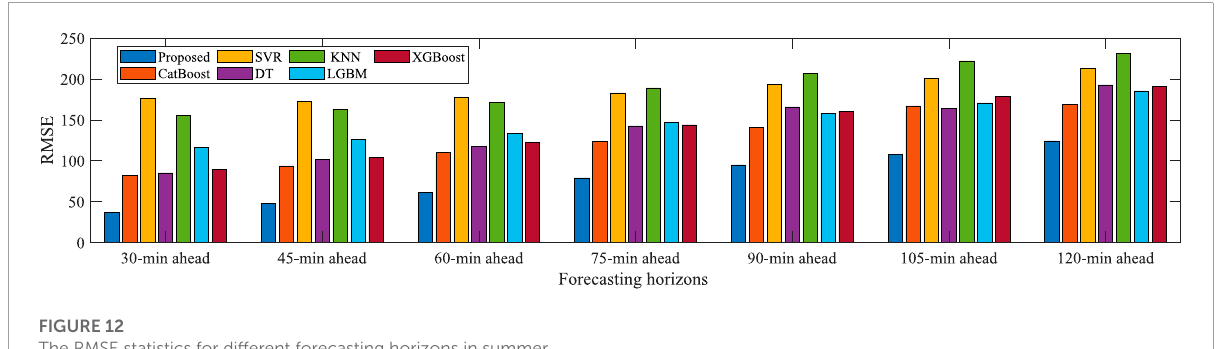
FIGURE 12 The RMSE statistics for different forecasting horizons in summer.